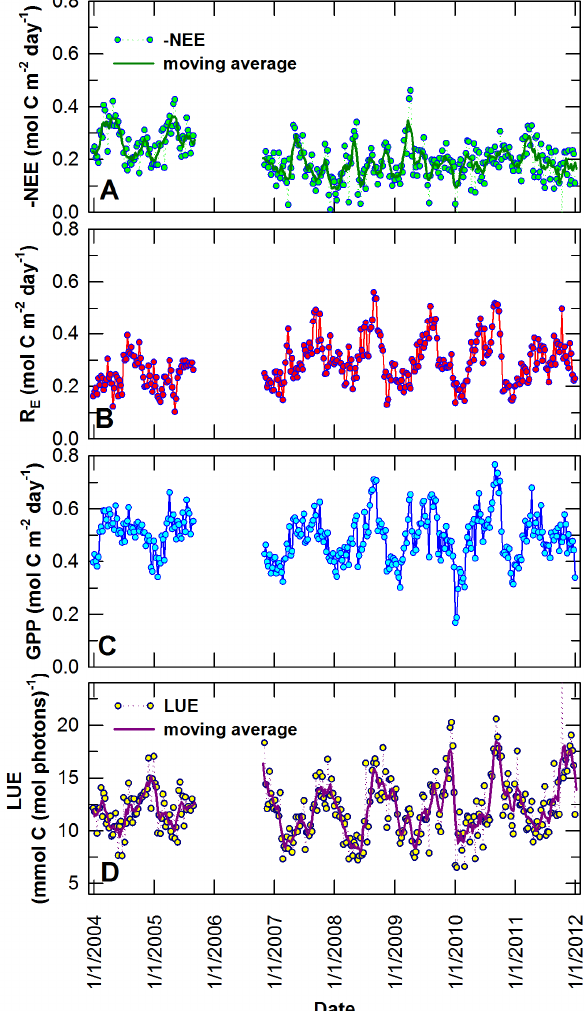
Fig. 4. Eight-day averages of photosynthetic active irradiance, PAR; mol(photons)m − 2 day − 1 (A) and air temperature ( ◦ C) (B) at a height of 27m at the SRS6 tower site. Eight-day average surface water salinities (ppt) (C) measured from a well at the USGS SH3 site adjacent to the tower.